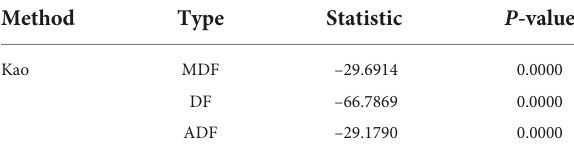
TABLE 4 Cointegration